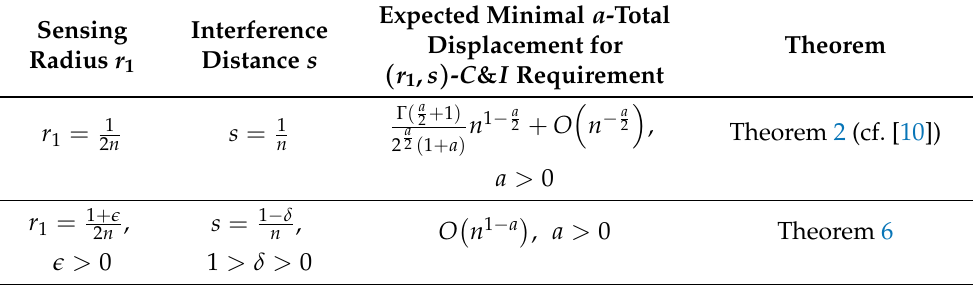
Table 1. The expected minimal a -total displacement of n random sensors on the unit interval [ 0,1 ] as a function of the sensing radius r 1 and the interference value s , where (cid:101) > 0, 1 > δ >